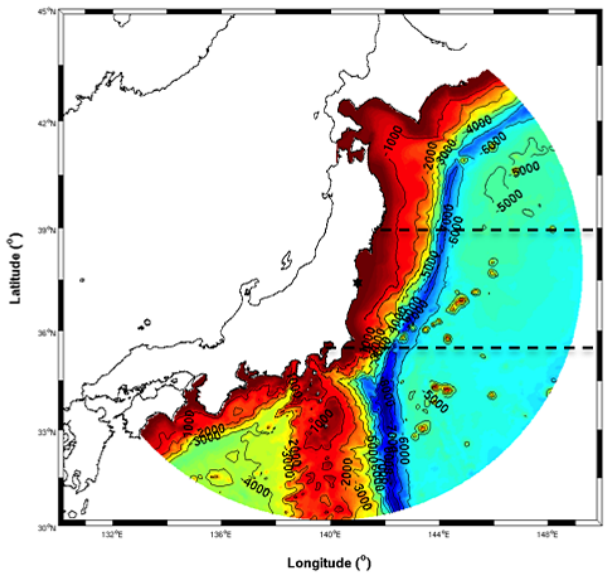
Figure 1. Numerical domain and its bathymetry. The dashed lines indicate the limits of the three regional areas: the subtropical region (latitude<35 ◦ N), the transition region (35 ◦ N<latitude<39 ◦ N), and the subarctic region (latitude>39 ◦